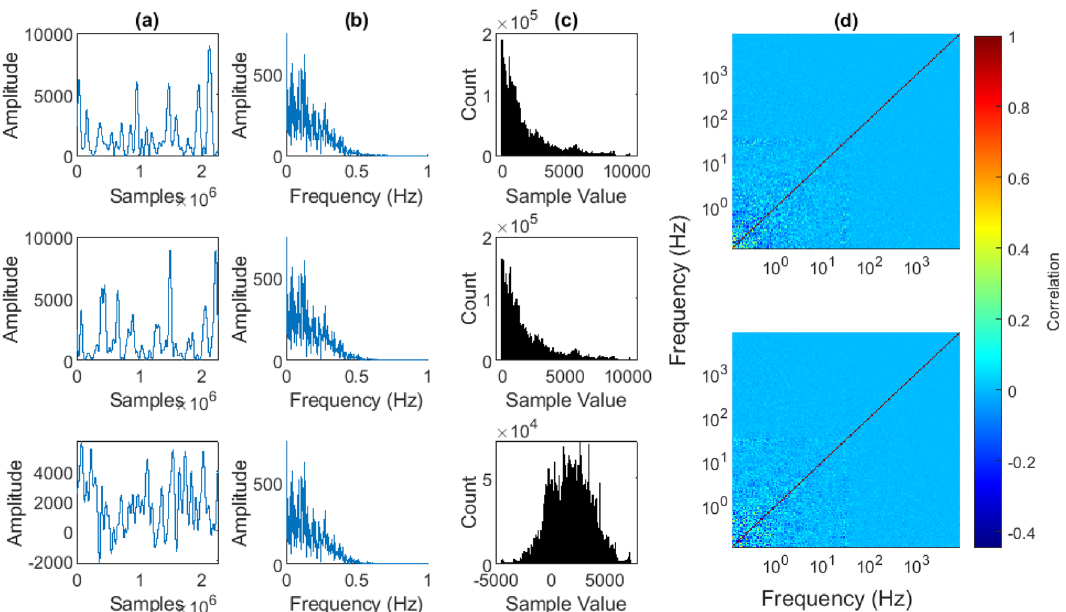
Figure 11. Effects of IAAFT and FT phase randomisation on intra-scale data. Top: original neural data from Session 1, Chan. 1, Scale 130 (central frequency of 1.1 Hz). Middle: IAAFT phase-randomised data. Bottom: FT phase-randomised data. ( a ) Time-series sample. ( b ) Fourier transform. ( c ) Time-series histogram. ( d ) Phase- randomised ISPCM example for IAAFT (top) and FT method (bottom), from Session 1, Chan.